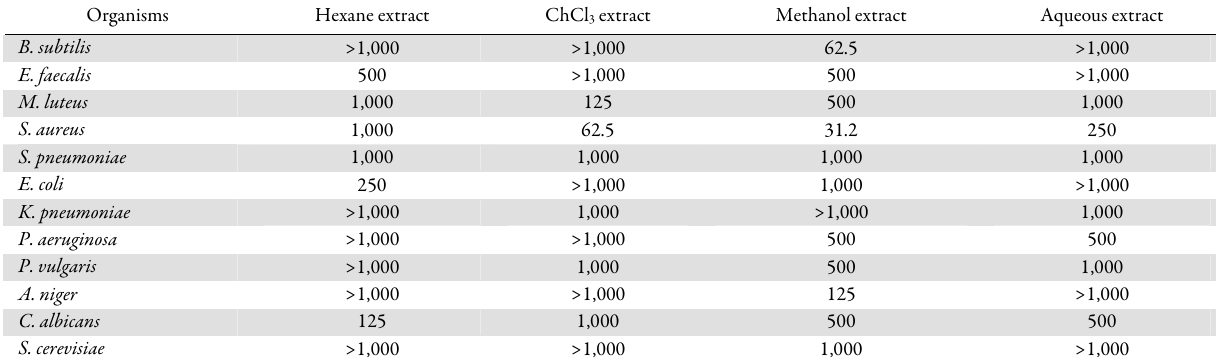
a : Each value is the mean of three replicates with standard deviation; P value is < 0.01 extremely significant when compared with standard, S: Standard antibiotics, T : Tetracycline; F : Fluconazole, D: DMSO, –: No activity Table 2. MIC values of Rauwolfia serpentina root extracts against bacteria and fungi Organisms Hexane extract ChCl 3 extract Methanol extract